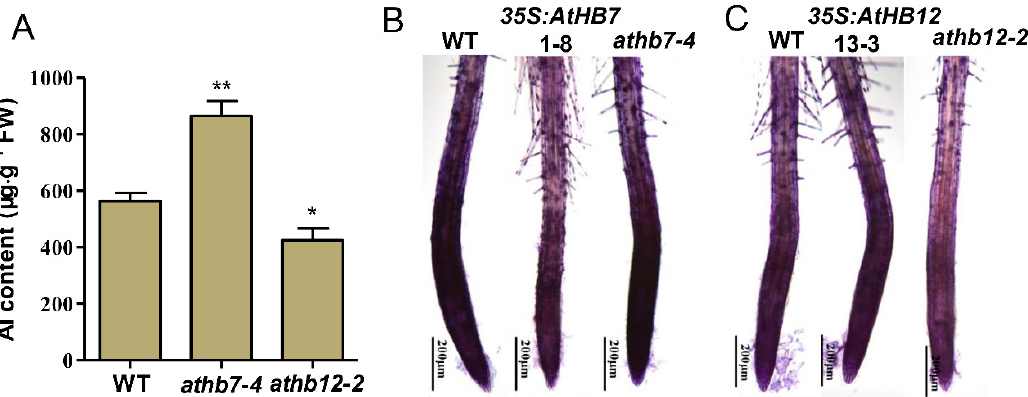
Figure 6. AtHB7 and AtHB12 oppositely regulate Al binding to cell wall. ( A ) Analysis of Al content in roots of wild type, athb7 and athb12 mutants. AtHB7 ( B ) and AtHB12 ( C ) a ff ect Al accumulations in cell walls of root tips indicated by hematoxylin staining. Asterisks indicate significant di ff erences between wild type and mutants at *: p < 0.05 and **: p < 0.01 by Tukey’s